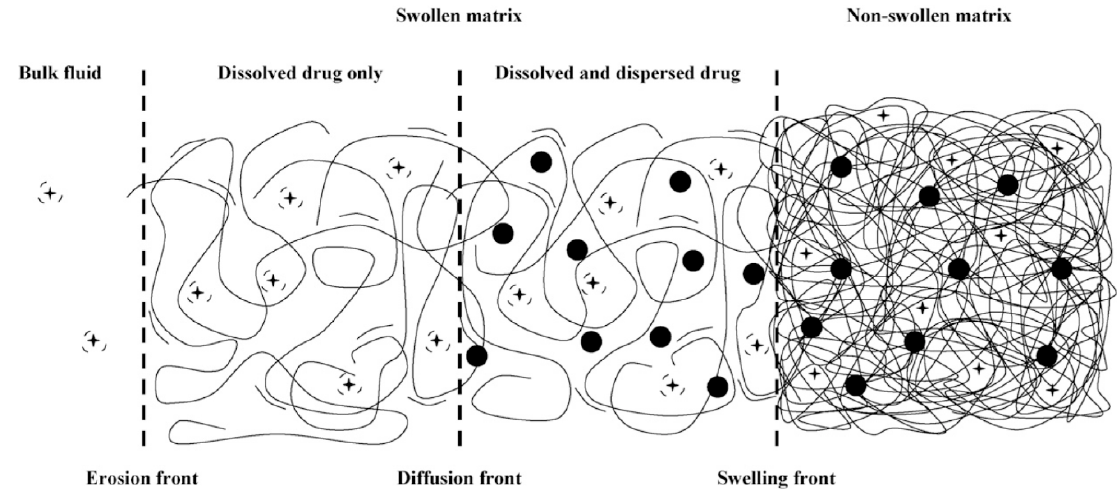
Figure 1. Representation of a swelling-controlled system with different zones separated by moving boundaries. Reprinted from Siepmann and coworkers [28], Copyright 2008 Elsevier.